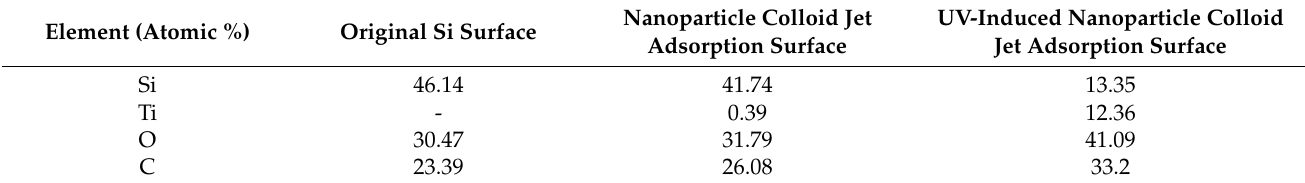
Table 2. Relative content of some major elements on each test sample.